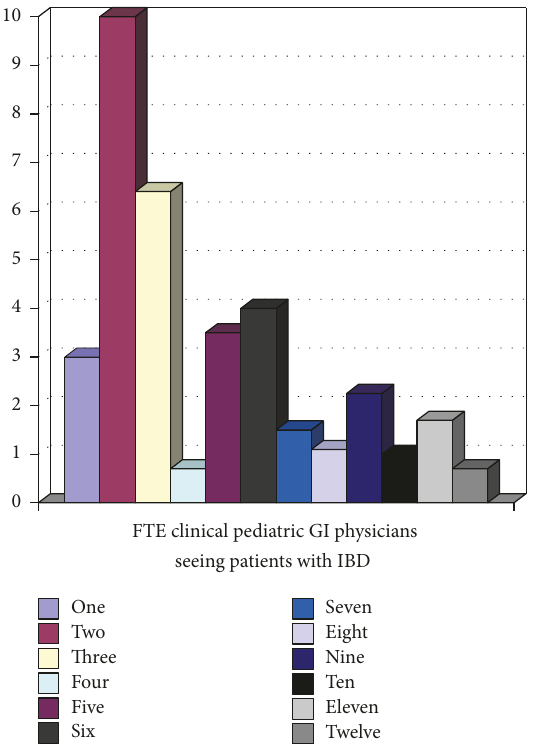
Figure 1: Full-time equivalent (FTE) pediatric gastroenterologists for children with IBD per centre.